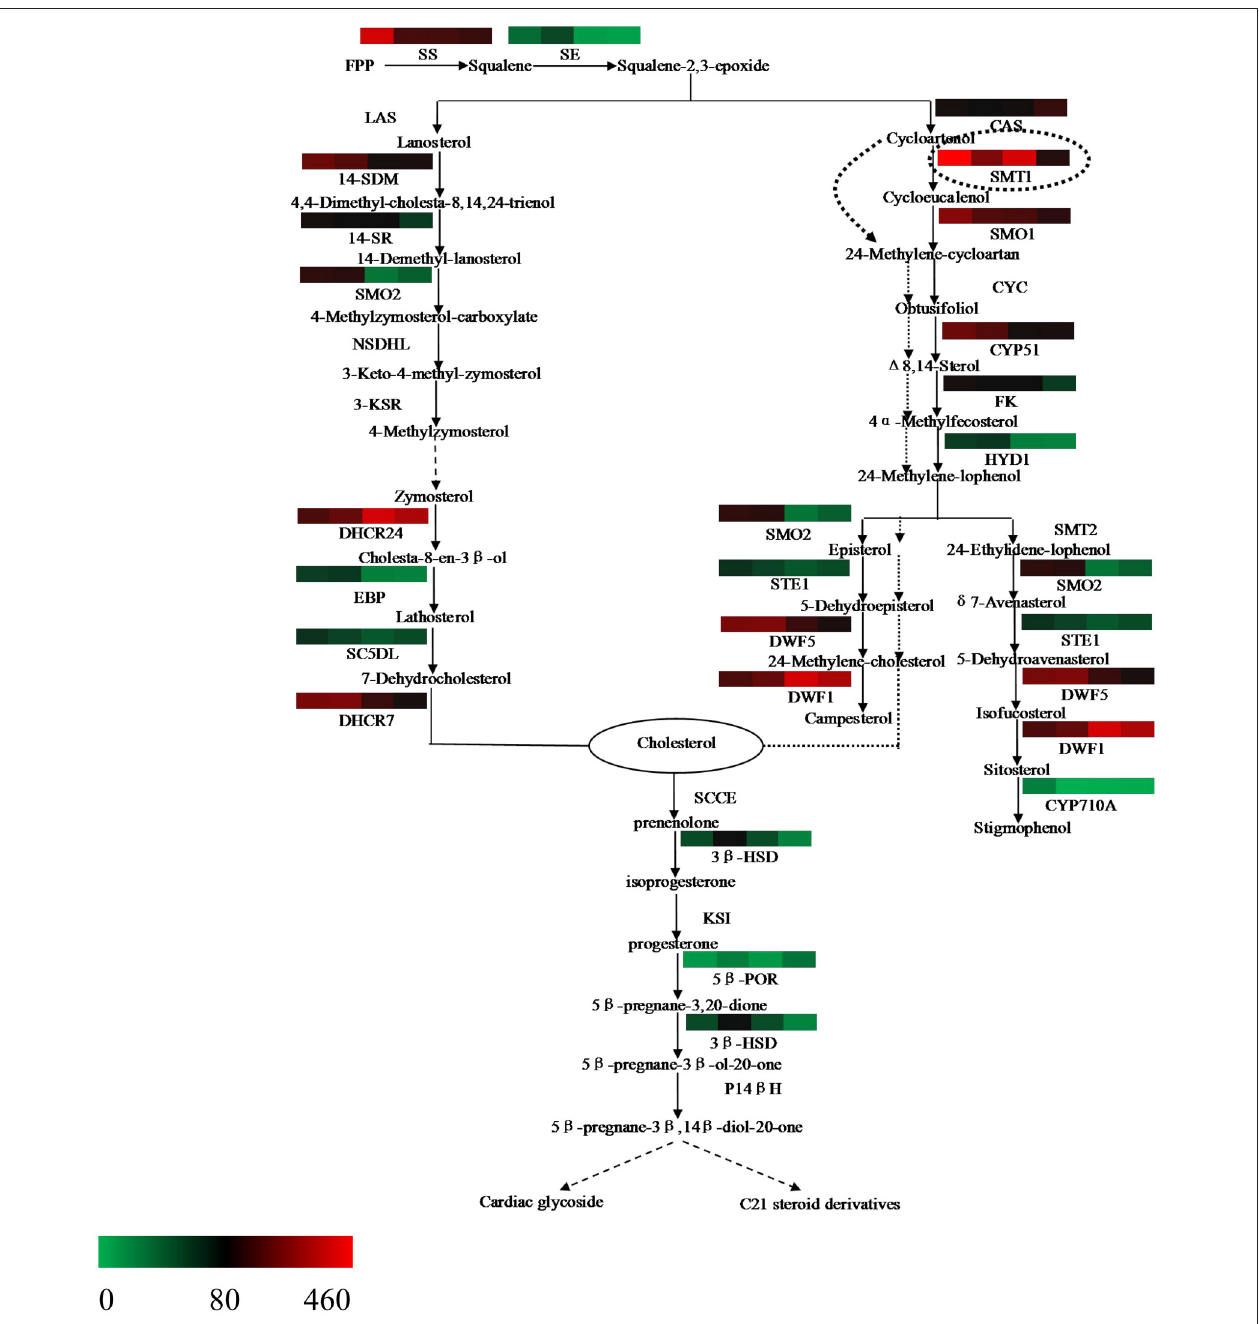
FIGURE 6 | Putative bioactive steroid biosynthesis in Periploca sepium. Enzymes involved in bioactive steroid biosynthesis are shown. The expression of genes encoding these enzymes in AR, C, R, and L is shown by the heat-map. The genes were mapped using RPKM values and color coded by increasing relative expression. The broken arrow represents putative or unknown terminal biosynthesis steps for C21 steroids and cardiac glycoside. SS, squalene synthase; SE, squalene epoxidase; CAS, cycloartenol synthase; CYC, cycloeucalenol cycloisomerase; CYP51/14-SDM, sterol 14alpha-demethylase; CYP710A, sterol C-22 desaturase; DWF1/DHCR24, delta (24)-sterol reductase; DWF5/DHCR7, 7-dehydrocholesterol reductase; FK/14SR, delta(14)-sterol reductase; HYD1/EBP, C-8,7 sterol isomerase; LAS, lanosterol synthase; SMT, sterol C-24 methyltransferase; SMO, sterol-4alpha-methyl oxidase; STE1/SC5DL, delta(7)-sterol-C5(6)-desaturase; NSDHL, sterol-4alpha-carboxylate 3-dehydrogenase; 3-KSR,3-keto-steroid reductase; 3 β HSD, 3-beta-hydroxysteroid dehydrogenase; 5 β POR, progesterone 5beta-reductase; SCCE, cholesterol monooxygenase, side chain-cleaving enzyme; KSI, delta 5-delta 4-ketosteroid isomerase; P14 β , pregnane 14-beta hydroxylase.